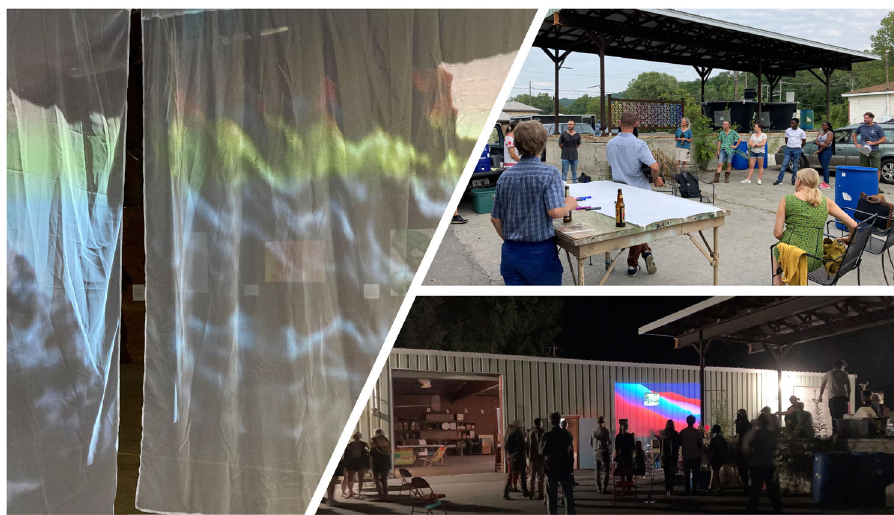
Fig. 6 Synchronous and asynchronous interactions by diverse participants to test lessons learned for an undisciplinary center. Left: View through a multi-projection installation by Paulina Velazquez Solis onto a wall showing prints by the art group Franja CentroAmerica (https://franjacentroamerica. com/) next to students responding to questions about motivations for engaging in a hypothetical “ interdisciplinary center ” (July 8, 2021); upper right: workshop on circular bio-nutrient economy using large tables on wheels with paper where conversations remain as a visible record later hanging on a wall (August 26, 2021); lower right: performances inside/outside thematizing water and environmental quality (August 14, 2021) (all images The Soil Factory,